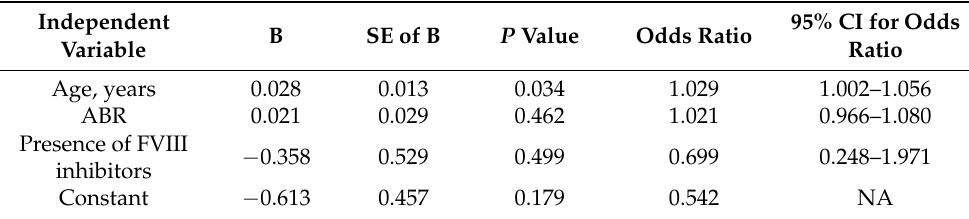
Table 2. Factors associated with spontaneous bleeding during emicizumab prophylaxis (as assessed by binomial logistic regression analysis). Independent B SE of Variable